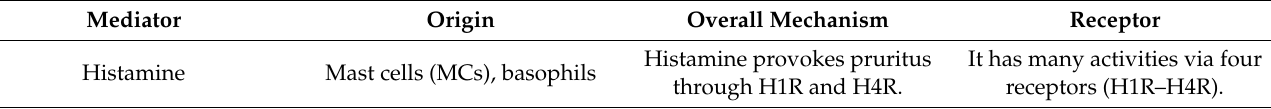
Table 1. An overview of important pruritogenic mediators in atopic dermatitis